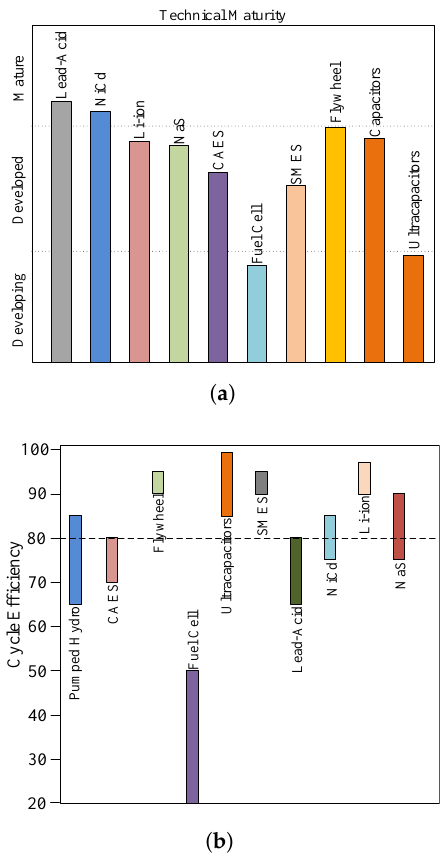
Figure 4. ( a ) Maturity and ( b ) Efficiency of different energy storage systems